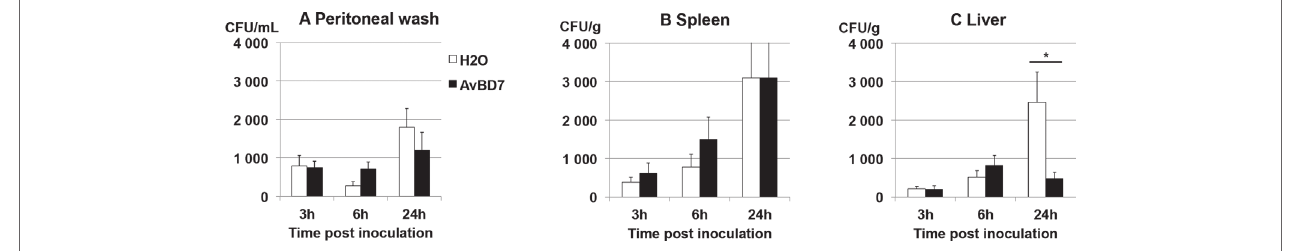
FIGURE 6 | Kinetics of Salmonella multiplication in the peritoneal cavity or organs of infected mice after treatment or not with AvBD7. BALB/c mice infected by S . Typhimurium were treated with AvBD7 (black bars) or not (white bars), as indicated in the Materials and Methods. Values are given as mean number of CFU per ml of peritoneal liquid (A) or per g of spleen (B) or liver (C) , at the indicated time in h, ± standard error of the mean ( n = 10). Asterisk indicates significant difference between treated and mock treated mice ( p = 0.03).